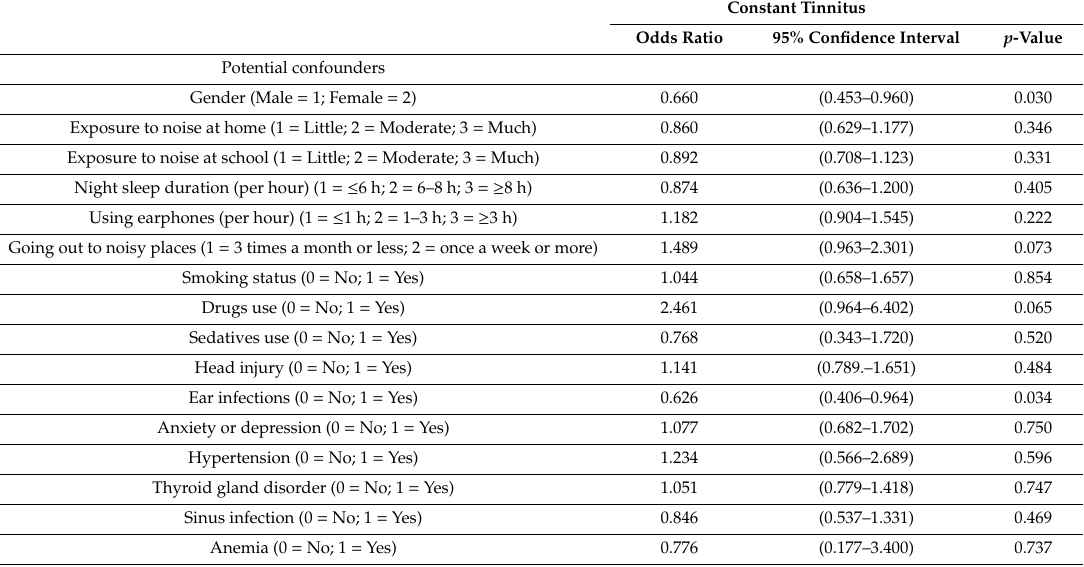
Table 2. The univariate logistic regression between personal factors and tinnitus among adolescents ( n =